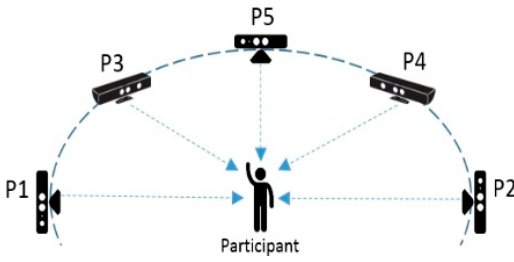
Figure 7. Arrangement of Kinect sensors in our experiment.